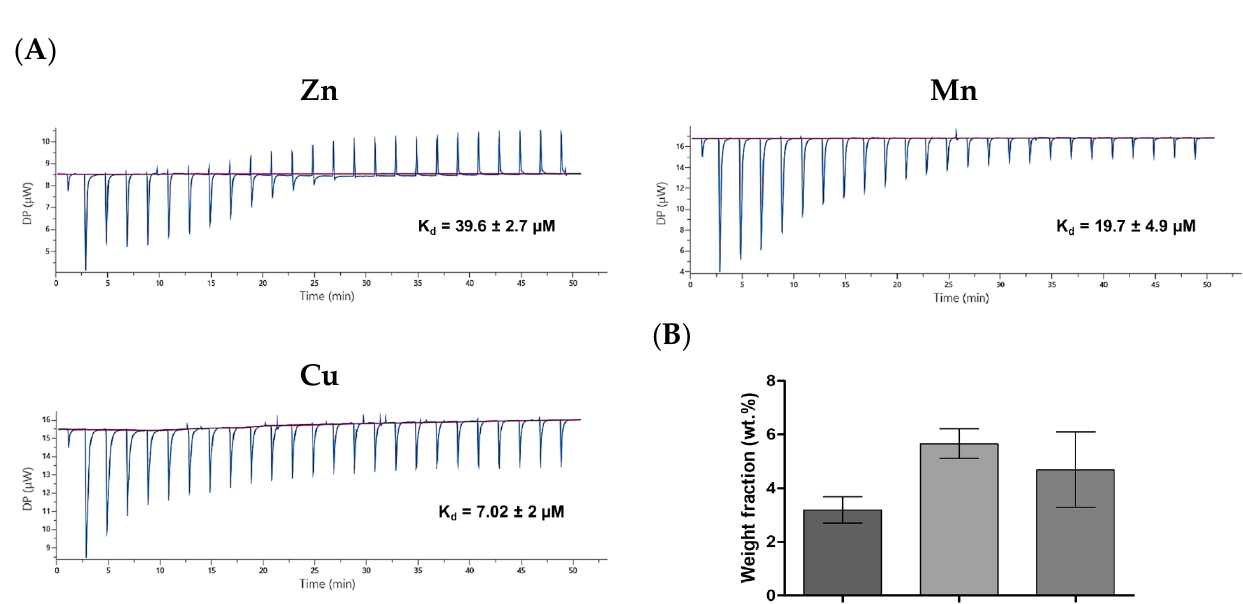
Figure 5. ( A ) Binding of di-histidine peptide to divalent metals (Cu, Zn, or Mn) according to isothermal titration calorimetry (50 mM HEPES, pH = 7.4, 37 ◦ C). Integrated data for the titration after subtraction of control are shown. ( B ) SEM-EDX analysis of elemental composition of TM-modified C 12 PA gels.